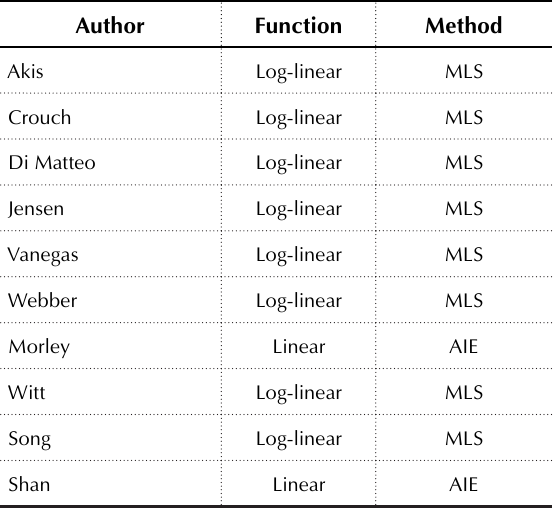
Table 3. Overview of methods of suggested